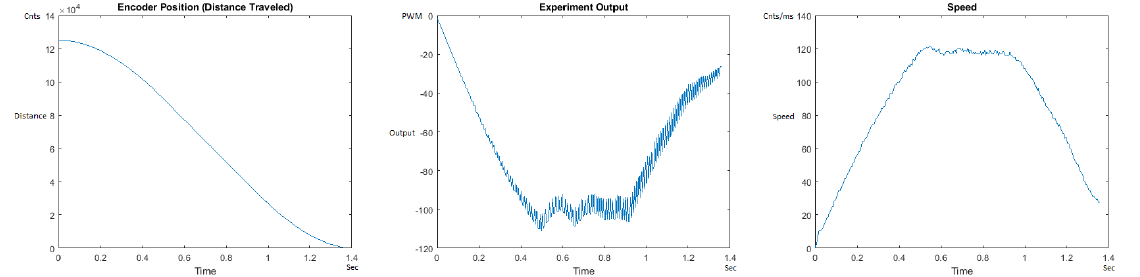
Figure 32. Encoder position, output and speed plots for PID++ DOWN operation— Vmax 120 cnts/ms, Adesired 0.055 cnts/ms 2 —1